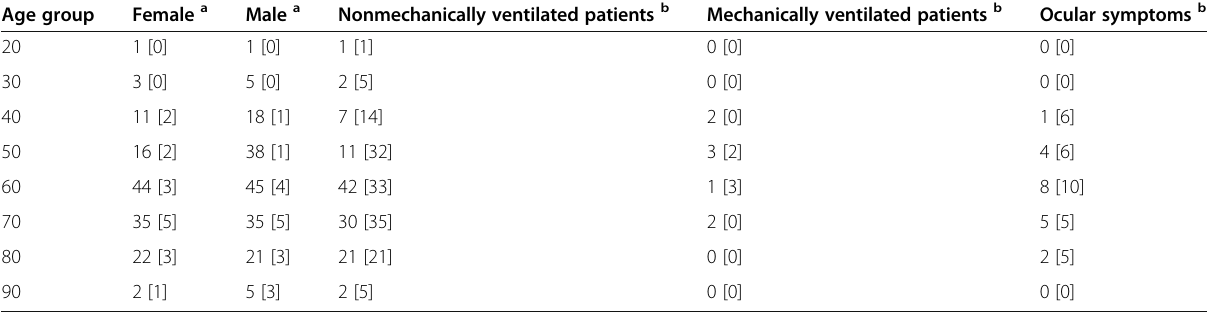
Table 2 The comparison of the number of all COVID-19 patients with the subset of those who were with positive PCR test in conjunctival sac swab stratified by age and gender